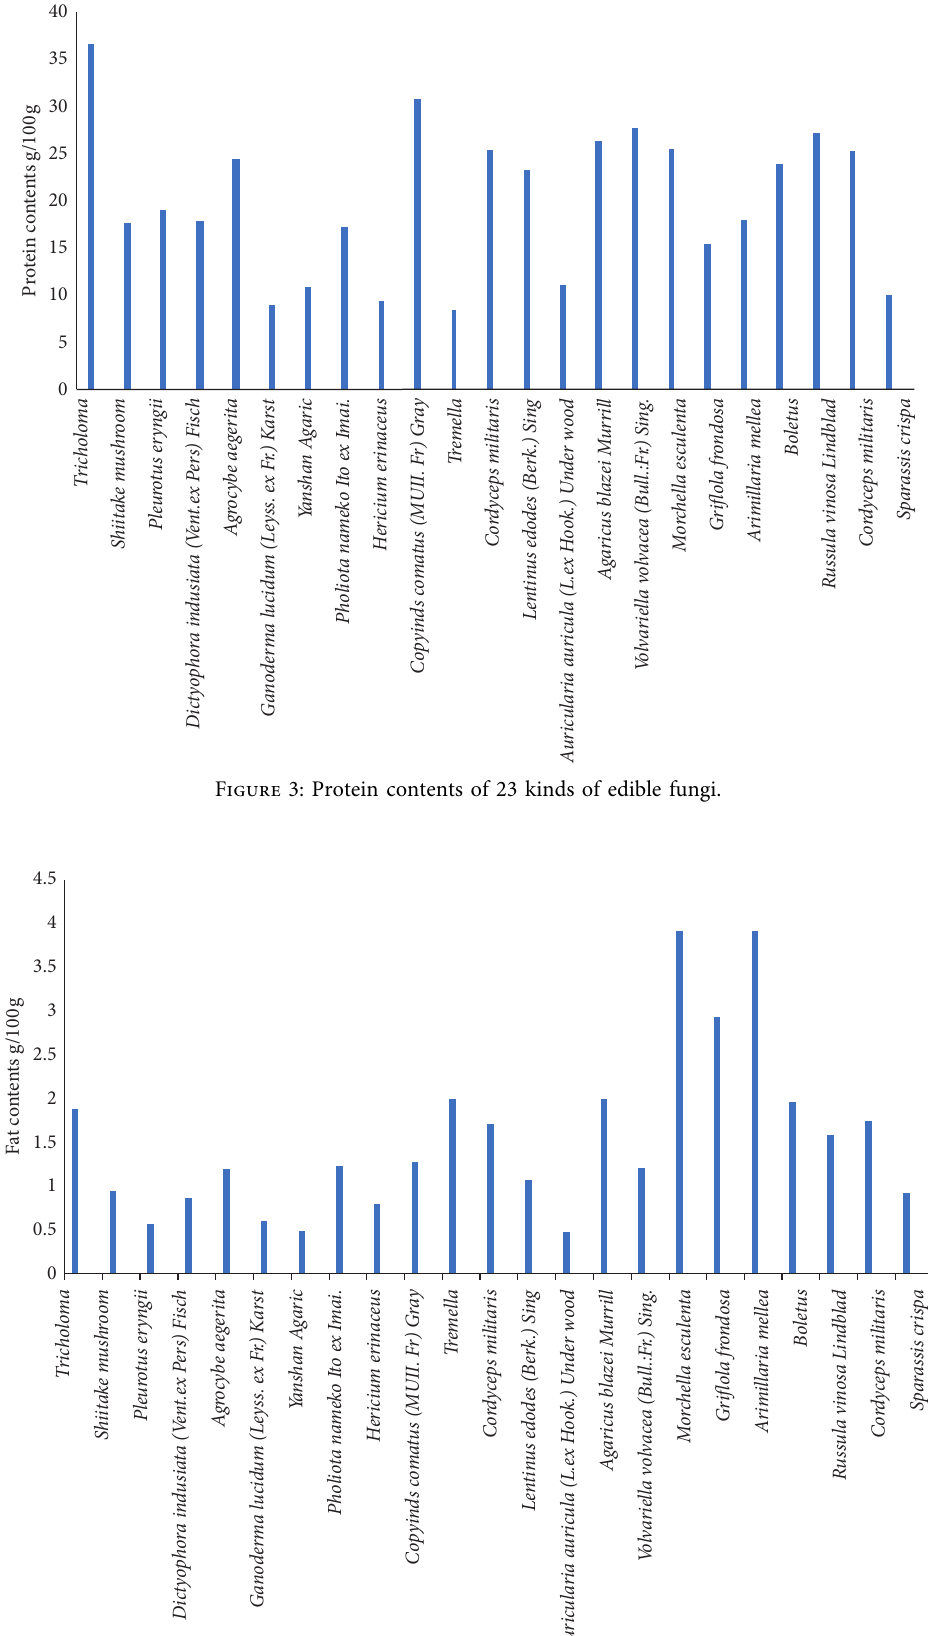
Figure 4: Fat contents of 23 kinds of edible fungi.